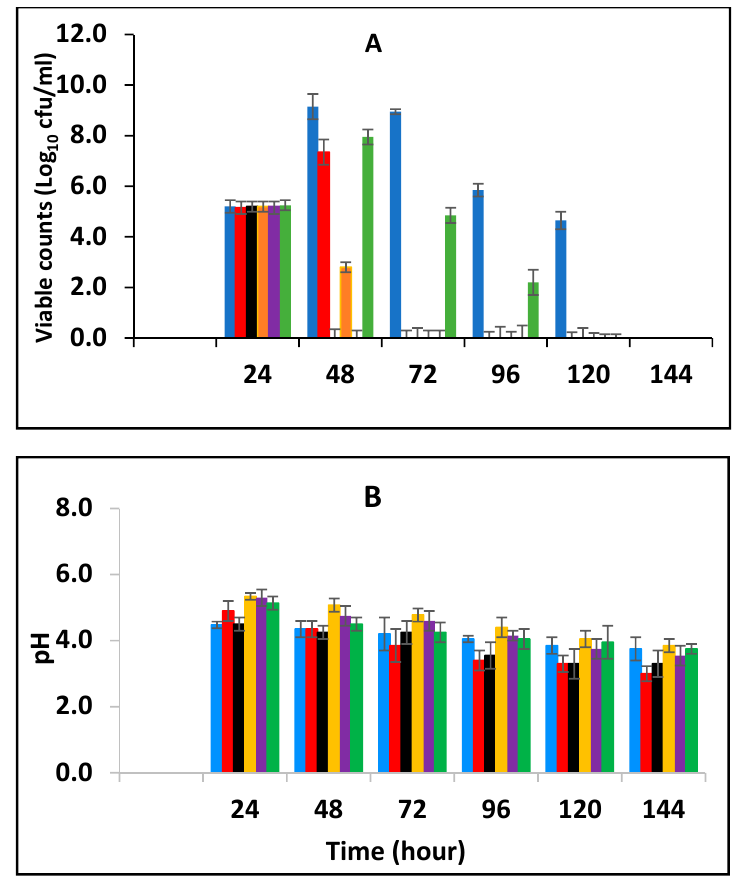
Figure 6. Survival of E. fergusonii ( A ) and change in pH ( B ) in the presence of essential oils of black pepper (BPE) and cinnamon extracts (CE) during storage at 25 ° C of yoghurt fermented at 43 ° C for 24 h., The EOs were added at different concentrations post milk fermentation. Concentrations are in % ( w / v ), values are the mean of three individual replicates (means ± SD). Control [ ] ; 0.5% BPE alone [ ◼ (cid:0) ] ; 0.1875% CE + 0.125% BPE [ ◼ (cid:0) ]; 0.125% CE + 0.25% BPE [ ◼ (cid:0) ]; 0.0625% CE + 0.375% BPE [ ◼ (cid:0) ]; 0.25% CE alone [ ◼ (cid:0) ].